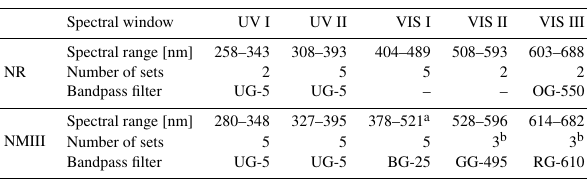
Table D1. Measurement routines for field campaigns in the Nördlinger Ries (Germany; NR) and long-term observations on the German Antarctic station Neumayer III